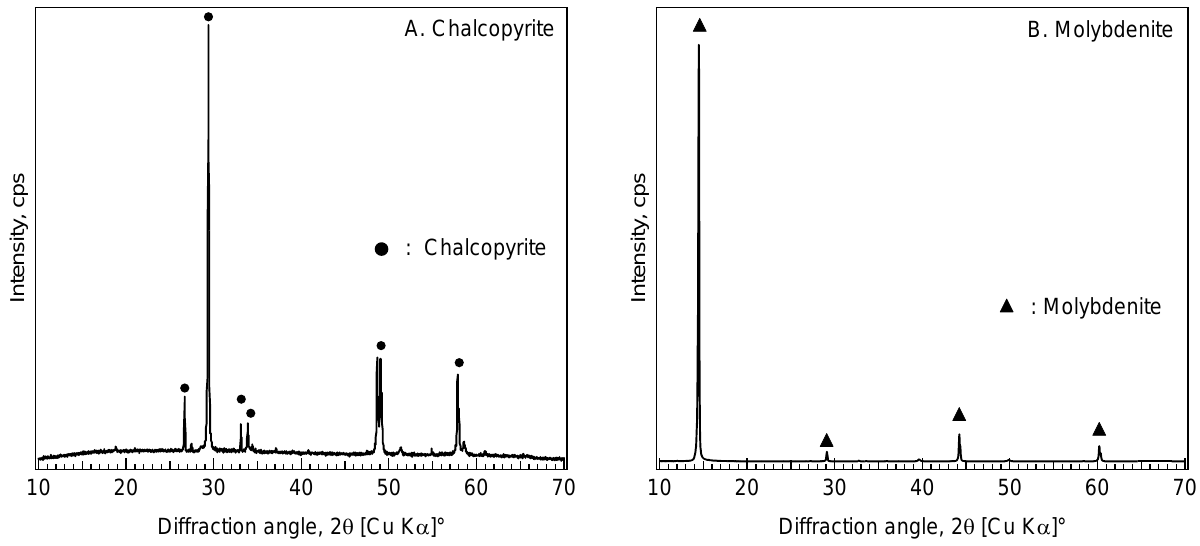
Figure 1. X-ray diffraction patterns of chalcopyrite ( A ) and molybdenite ( B ). Analytical grade sodium metabisulfite (MBS) was employed as a copper depressant in this study. Analytical grade potassium hydroxide (KOH) and hydrochloric acid (HCl)